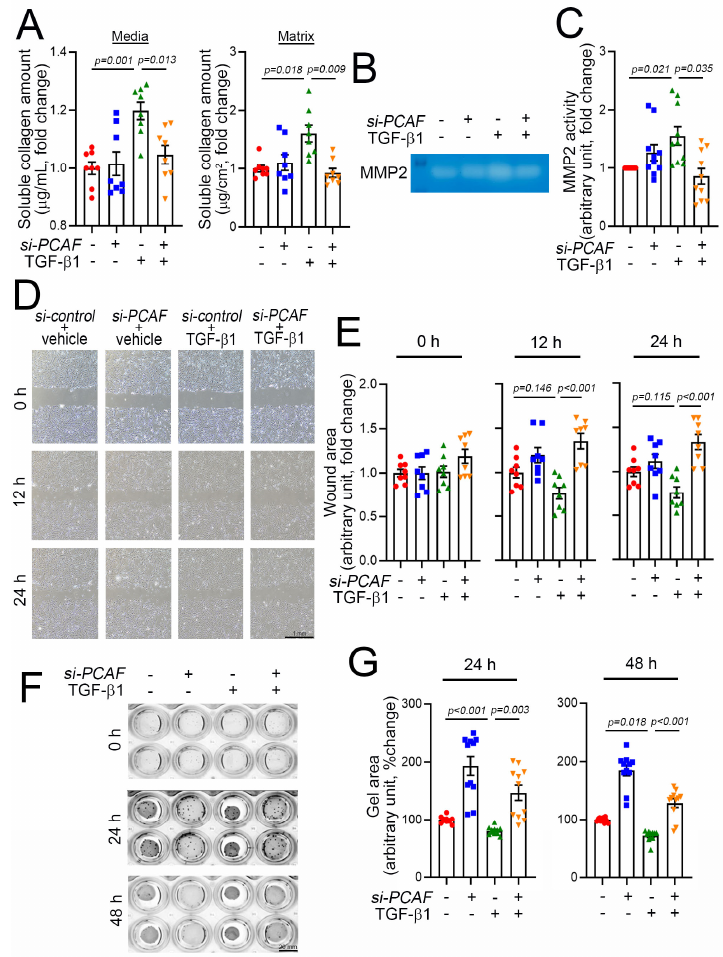
Figure 4. PCAF results in cardiac fibroblast contraction, migration, and MMP2 activity. ( A ) Changes in medial collagen in the culture media ( left ) and matrix collagen ( right ) on the well surface that were generated by human cardiac myofibroblasts. Notably, TGF- β 1-induced increases in both medial and matrix soluble collagen amounts were abolished by PCAF siRNA . ( B ) MMP2 activity determined by gelatin zymography assay. ( C ) Quantification result of the gelatin zymography assay. ( D ) Wound healing assay to observe the fibroblast migration ability. The photographs were taken 0, 12, and 24 h after the scratch of the confluently cultured myofibroblasts. See the methods for detailed explanation. ( E ) Quantification results. The wound area (cell-free area) was measured by ImageJ software as described in the methods. TGF-β1 showed a tendency to reduce the wound area, which suggested increased migration (3rd bars and green dots at 12 h and 24 h). However, the migration was significantly inhibited by PCAF siRNA (4th bars and orange dots in 12 h and 24 h). ( F ) TGF- β1-induced gel contraction assay (3rd row in the wells), which was significantly attenuated by treatment with PCAF siRNA (4th row) in 24 h and 48 h. See the methods for explanation. ( G ) Quantification results.